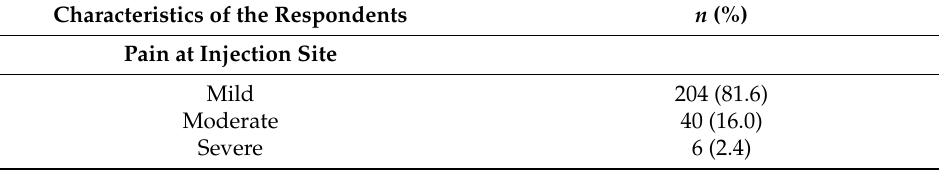
Table 2. Cont. Characteristics of the Respondents n (%) Pain at Injection Site Mild 204 (81.6) Moderate 40 (16.0) Severe 6